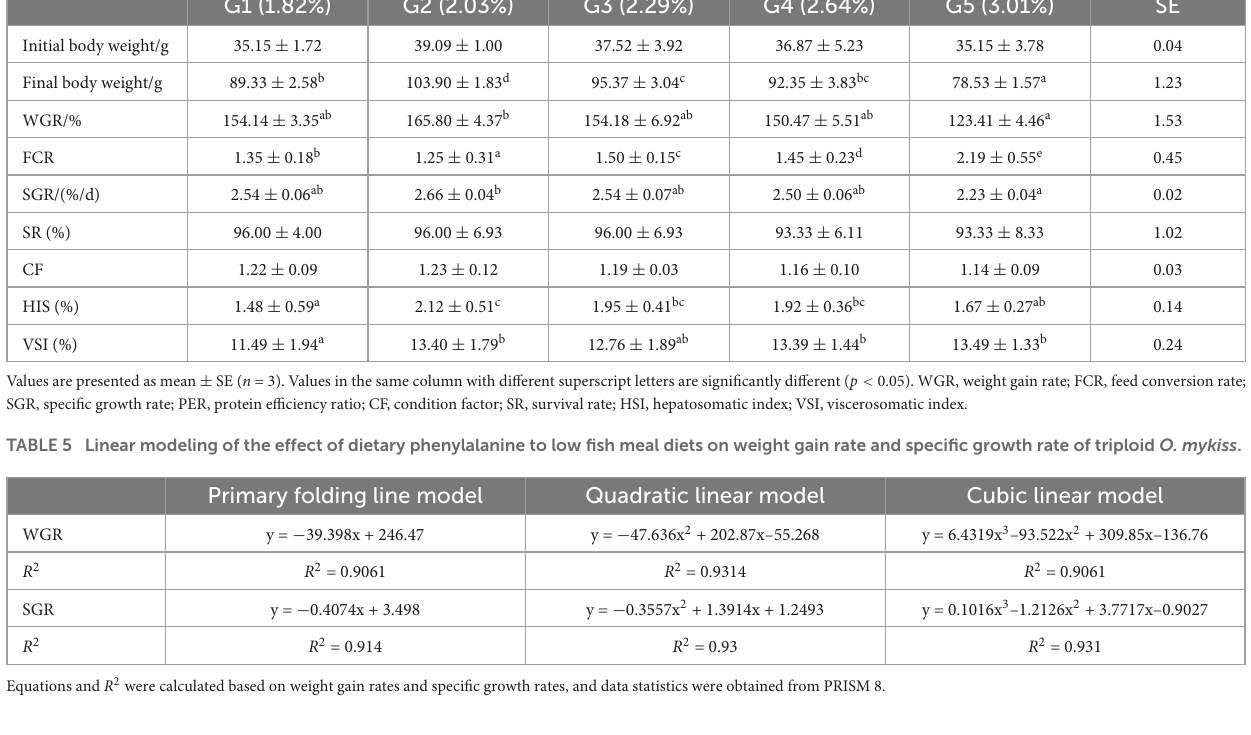
TABLE 4 Effects of dietary phenylalanine levels on the growth performance and somatic indices of triploid O. mykiss . Items Groups